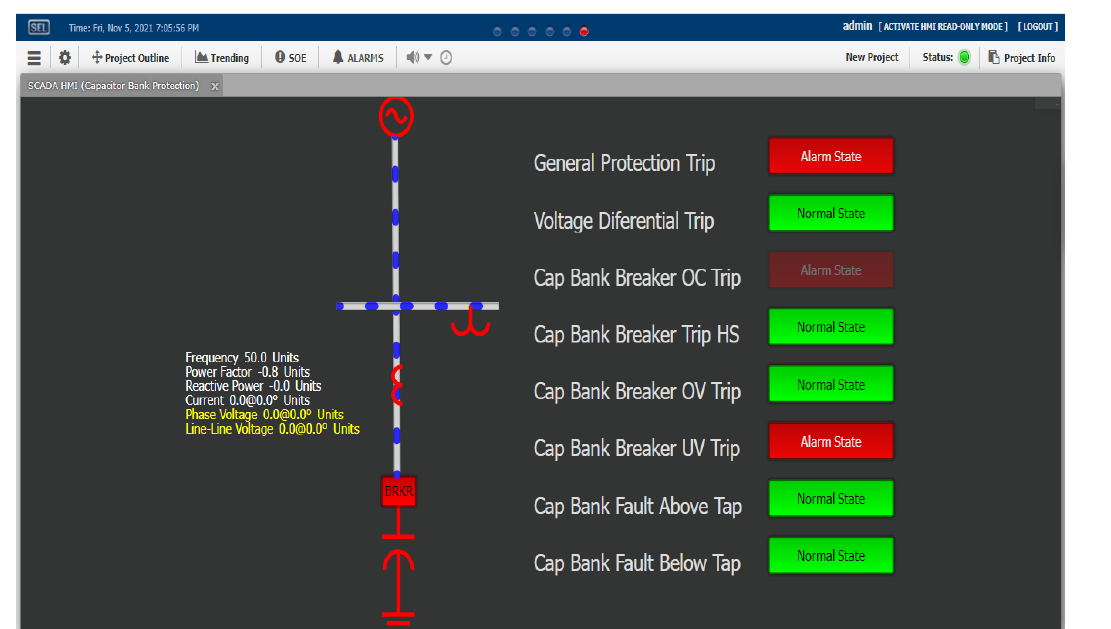
Figure 9. A human-machine interface for a simultaneous failure of six element failures above and below the tap.